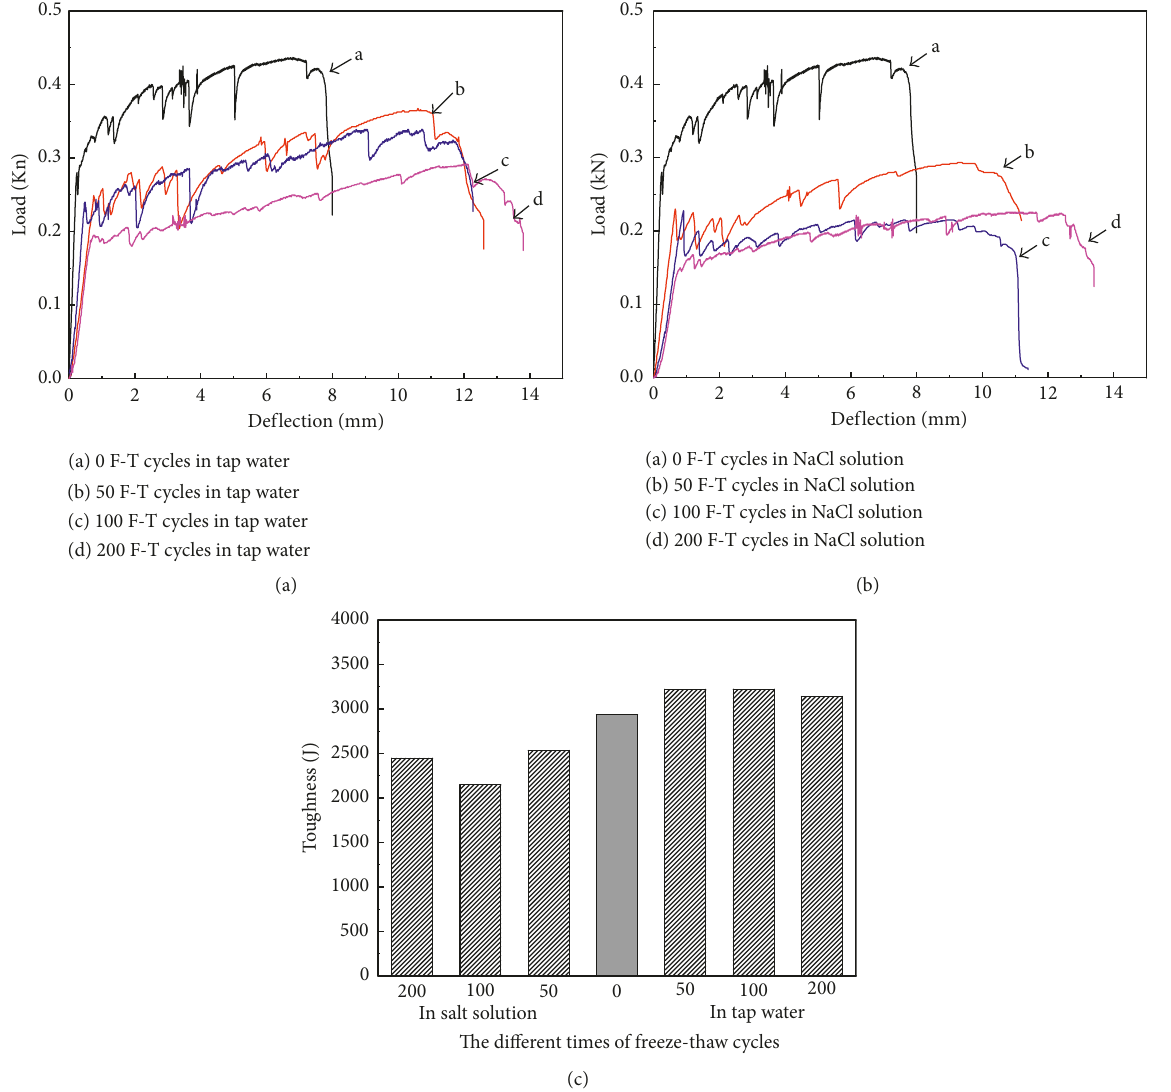
Figure 8: The load-deflection of ECC (30% FA+40% SL) subjected to different times of freeze-thaw cycle: (a) in tap water, (b) in sodium chloride (NaCl) solution, and (c) the corresponding toughness with different times of freeze-thaw